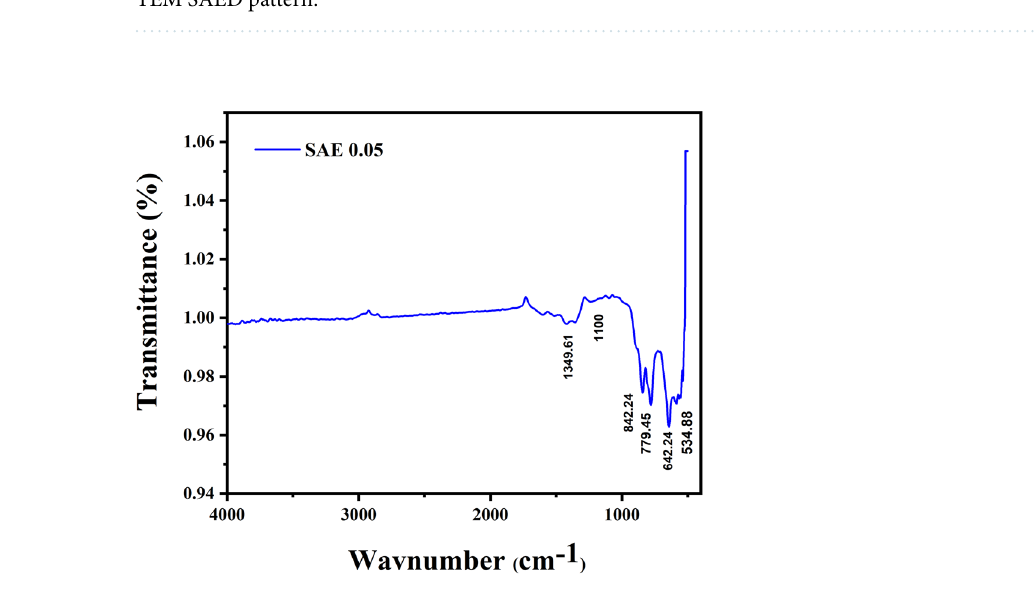
Figure 9. FTIR spectrum of Sr 1−x Al 2 O 4 :Eu x (x = 0.05) phosphor (SAE